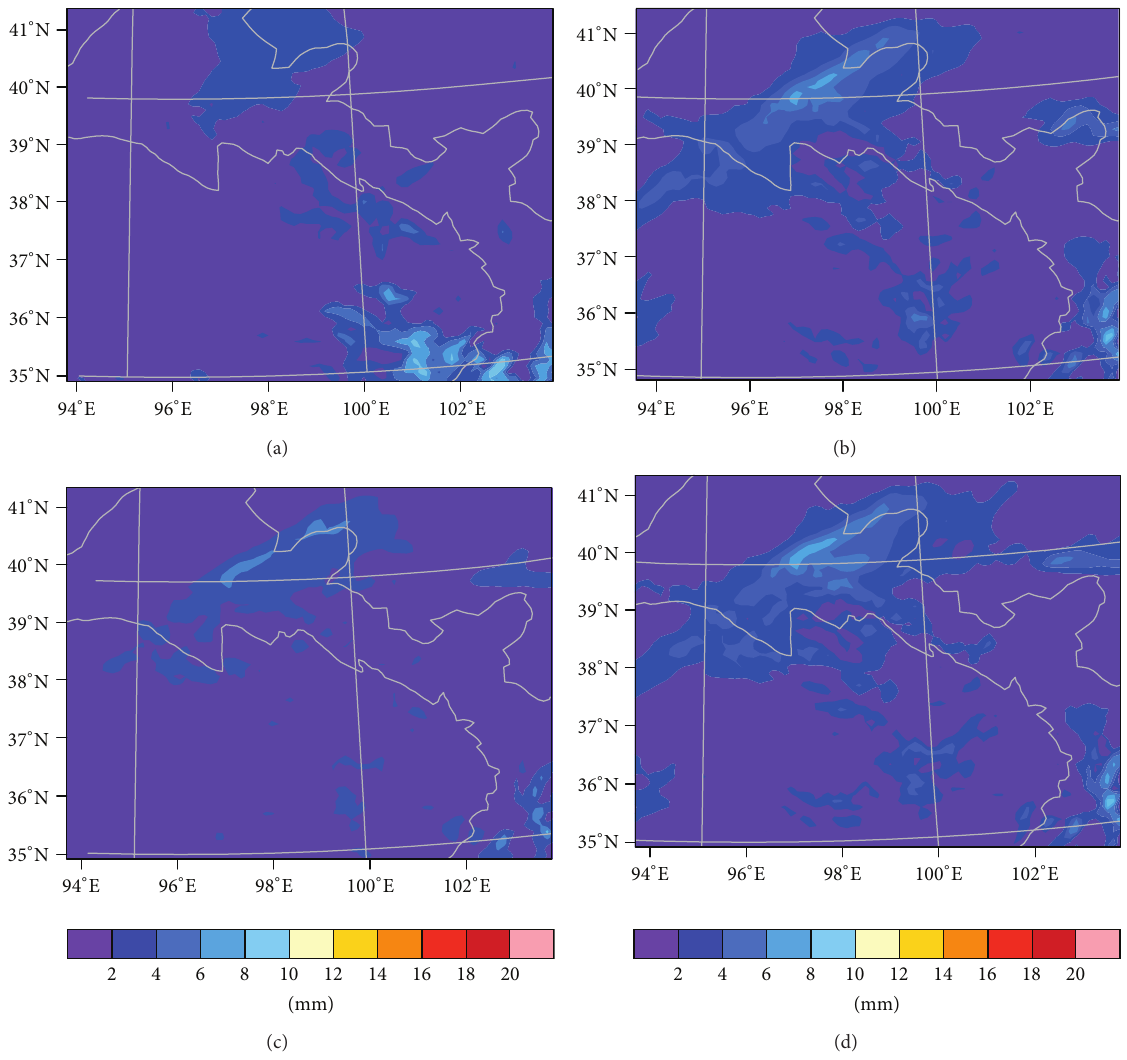
Figure 6: The forecast precipitation for Event B from the different numerical experiments: (a) CTRL; (b) DA-SAT; (c) DA-OBS; (d) DA-